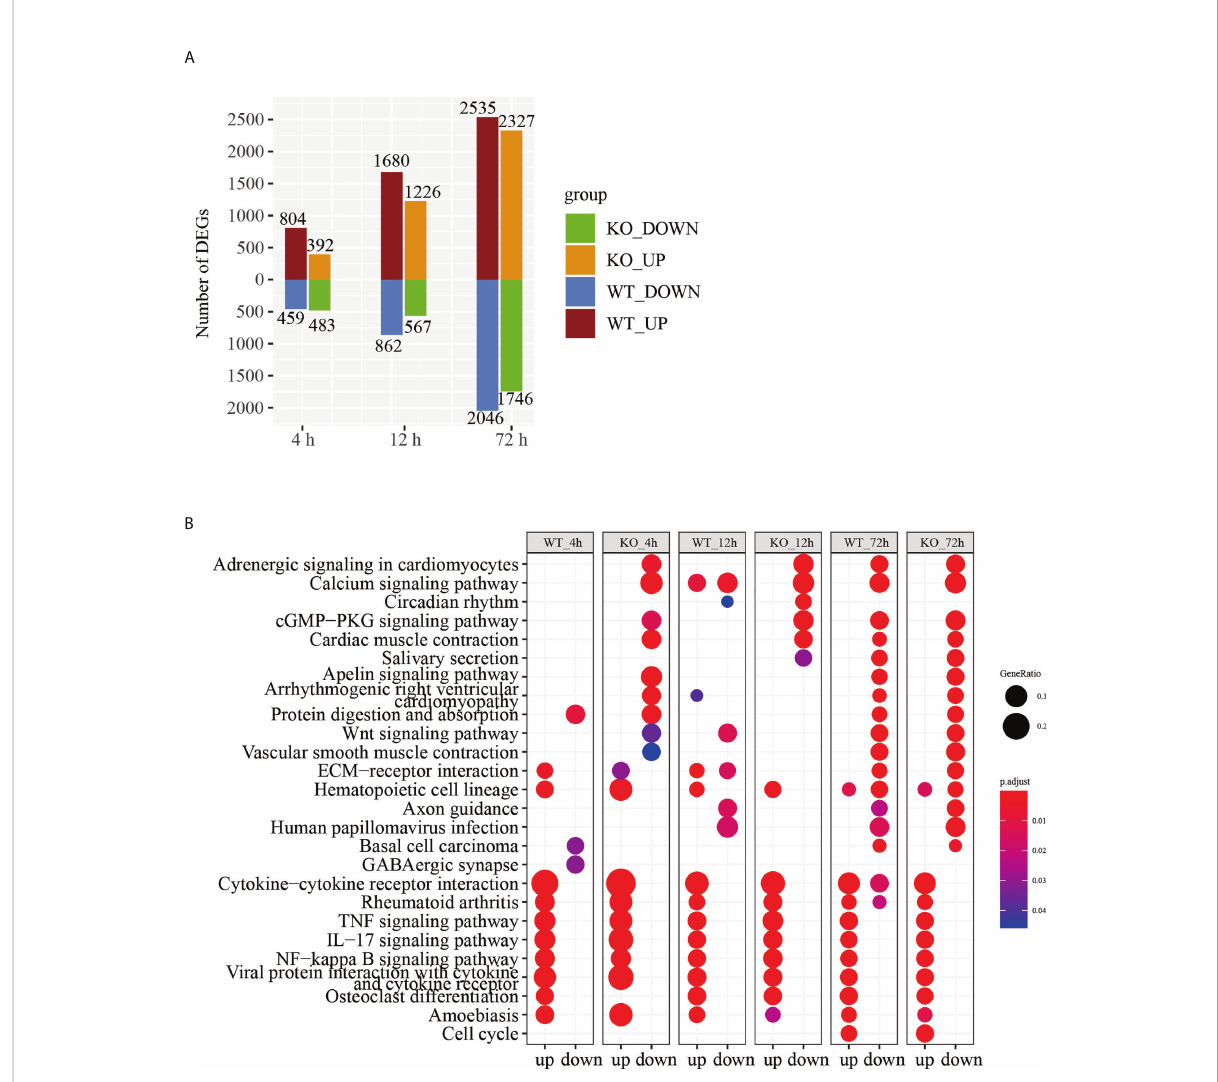
FIGURE 3 DEGs analysis of RNA-Seq in lung tissue of Csf2a KO mice and WT mice after RT-exposure compared to control. (A) Bar chart showing the number of DEGs under different experimental conditions. (B) The top 25 entries in the KEGG pathway with signi fi cant accumulation of up- and downregulated genes in each group under different experimental